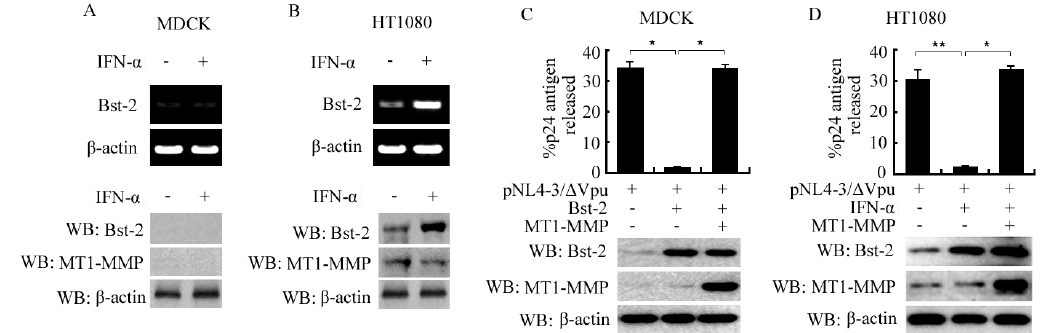
Figure 1. Expression of Bst-2 and its activity inhibition by MT1-MMP in MDCK cells and HT1080 cells. ( A , B ) Cells seeded in 6-plates were treated with or without IFN- α ; and then mRNA and protein levels of Bst-2 were assayed using RT-PCR and western-blot; ( C , D ) cells were divided into two parts and seeded in 6-plates overnight, plasmids pNL4-3/ Δ Vpu, Bst-2 and MT1-MMP were transfected or co-transfected in HT1080 cells and MDCK cells as described in figures; 48 h after transfection, one part culture for Bst-2 activity assay, the fractional release of p24 capsid was determined as the concentration of p24 antigen in the supernatants divided by the total concentration of p24 antigen in both the supernatants and cell lysates; the other part of the cells was for western-blot assay. * p < 0.01; ** p < 0.05.